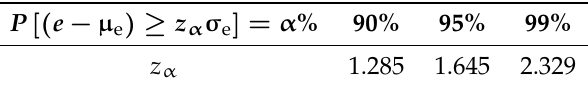
Table 2. Select of z α value.